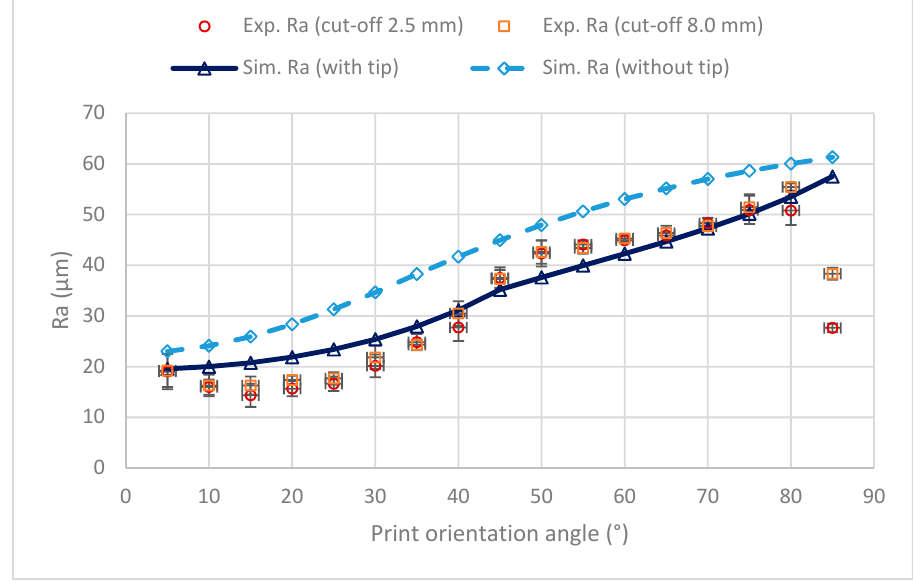
Figure 10. Arithmetical mean height (Ra) vs. print orientation angle .